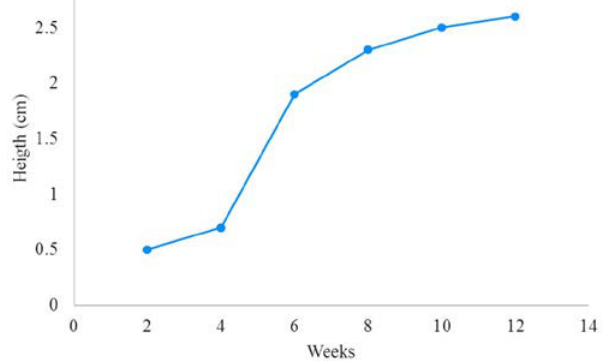
Fig. 3. The heights of A. capillus-veneris from week 2 to